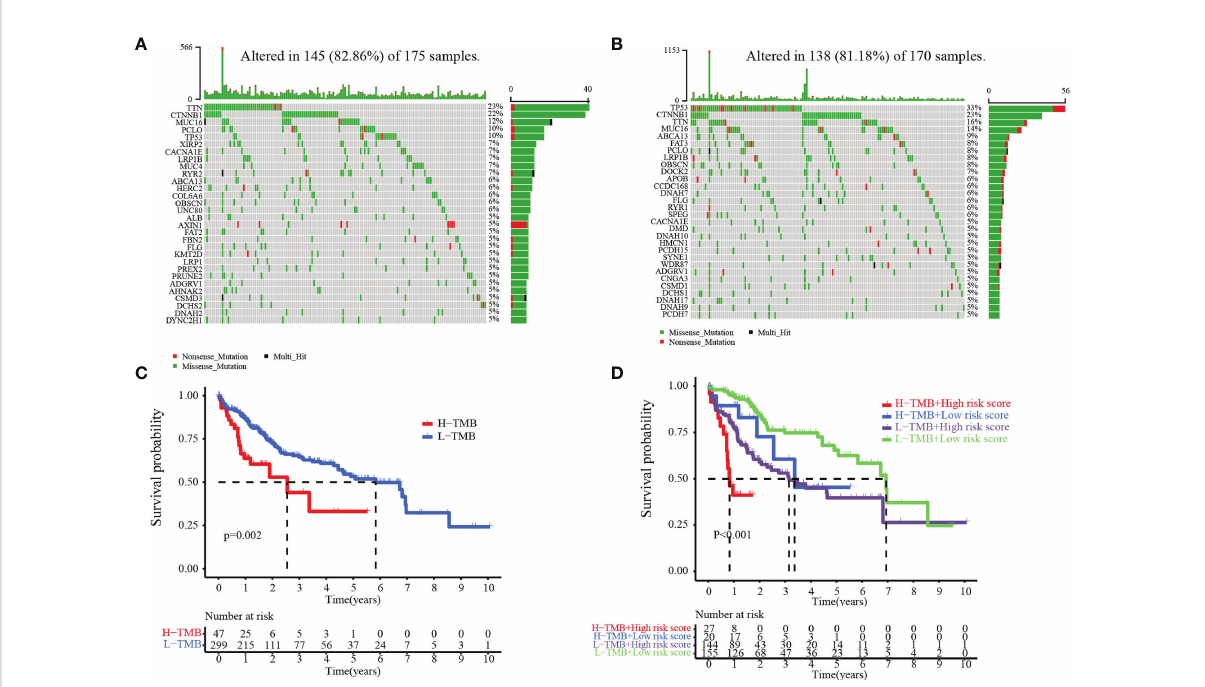
FIGURE 10 Relationship between the MARCH ligase signature and somatic mutation. Waterfall plots of 30 genes with the highest mutation rates in the high-risk group (A) and the low-risk group (B) . (C) Kaplan – Meier analysis of TMB in HCC patients. (D) Kaplan – Meier analysis of the correlation between risk score and